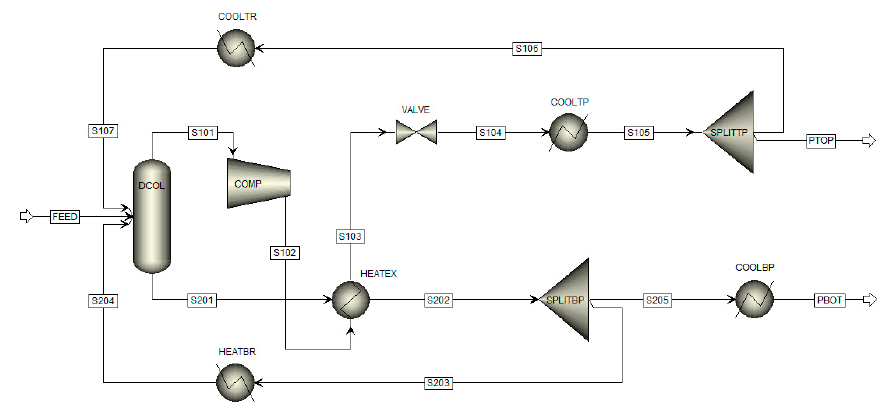
Figure 4. Schematic representation of the conventional VRC model in Aspen Plus ® [51].